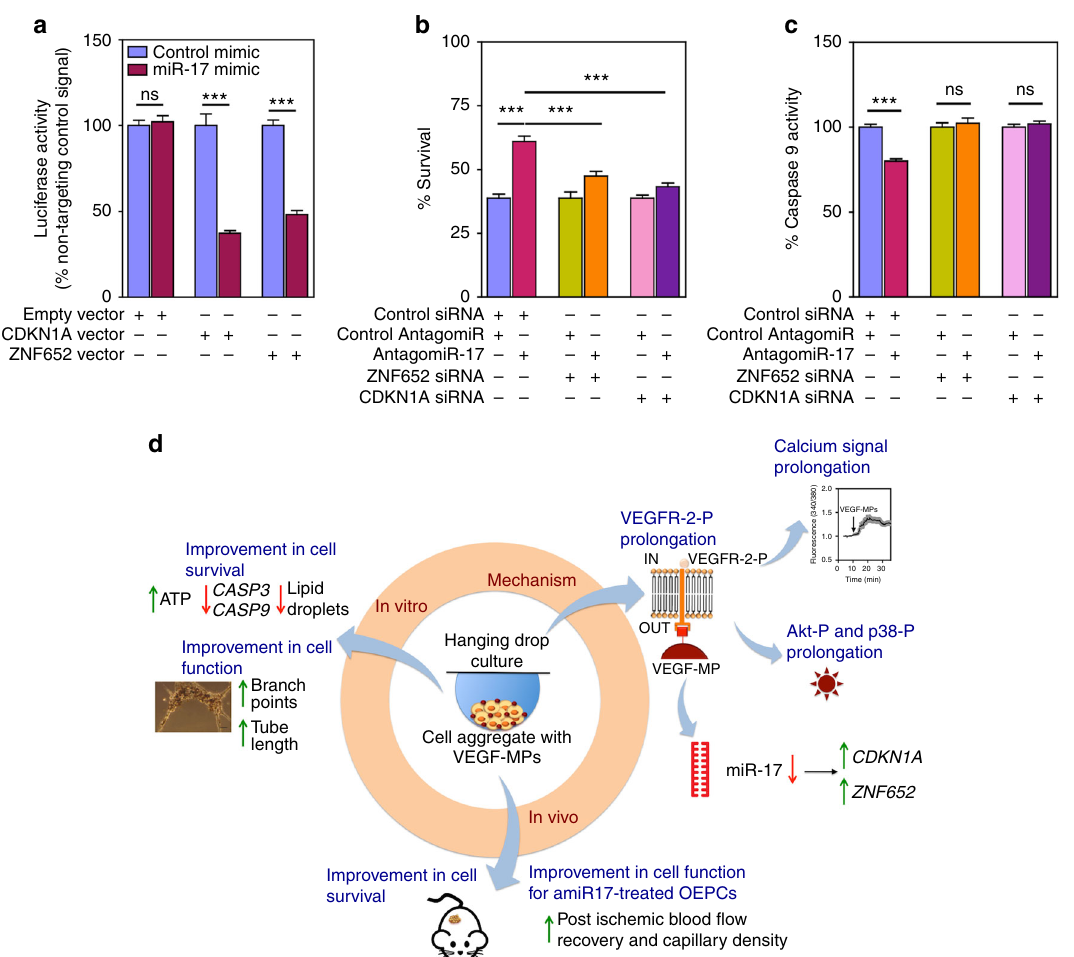
Fig. 7 AmiR-17 exerts its pro-survival effect by upregulating CDKN1A . a HEK293 cells were double transfected with 100 ng of each 3 ′ UTR luciferase reporter vectors (empty vector, CDKN1A vector or ZNF652 vector) and 50 nM miRNA mimics (control miRNA or miR-17 ). Signals from 3 ′ UTR reporters for the CDKN1A and ZNF652 were signi fi cantly knocked down when co-transfected with miR-17 , but not with control miRNA. No difference between control miRNA and miR-17 was observed when the empty vector was used. b , c OEPCs cultured in monoculture were silenced for ZNF652 and CDKN1A by the use of siRNA. After 2 days of transfection, OEPCs were washed and the cell culture medium was replaced by EBM-2 and cells were incubated under hypoxia conditions (0.1% O 2 ), with 5% CO 2 . After 48 h, both cell survival (by a Presto-Blue cell viability assay ( b )) and cell apoptosis ( c ) were evaluated. In b and c , the values are given as average ± SEM ( n = 10). Statistical analyses were performed using unpaired t- test. * P ≤ 0.05, ** P ≤ 0.01, and *** P ≤ 0.001. d Schematic representation of the action mechanism of the VEGF-conjugated microparticles used in this study. The interaction of conjugated VEGF with VEGFR-2 prolongs the phosphorylation of the receptor, calcium signaling and Akt phosphorylation compared with soluble VEGF group. Conjugated VEGF also downregulates miR-17 , which leads to the upregulation of CDKN1A expression. Activation of Akt and downregulation of miR-17 lead to an increase in